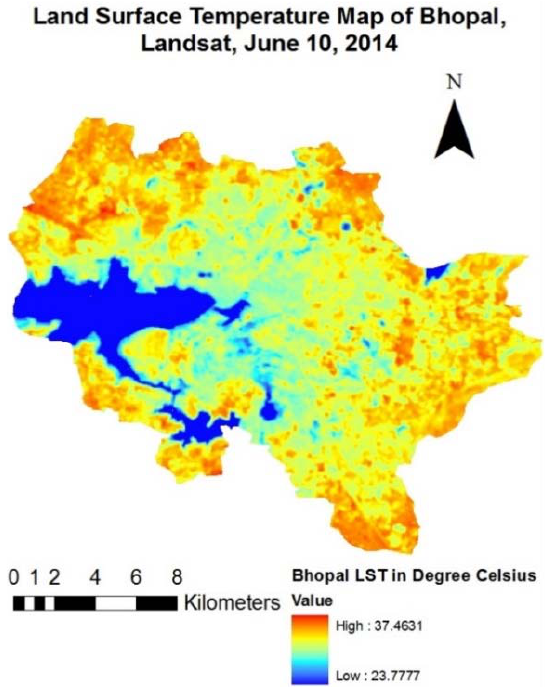
Fig. 4: Normalized difference vegetation index (NDVI) maps of Bhopal